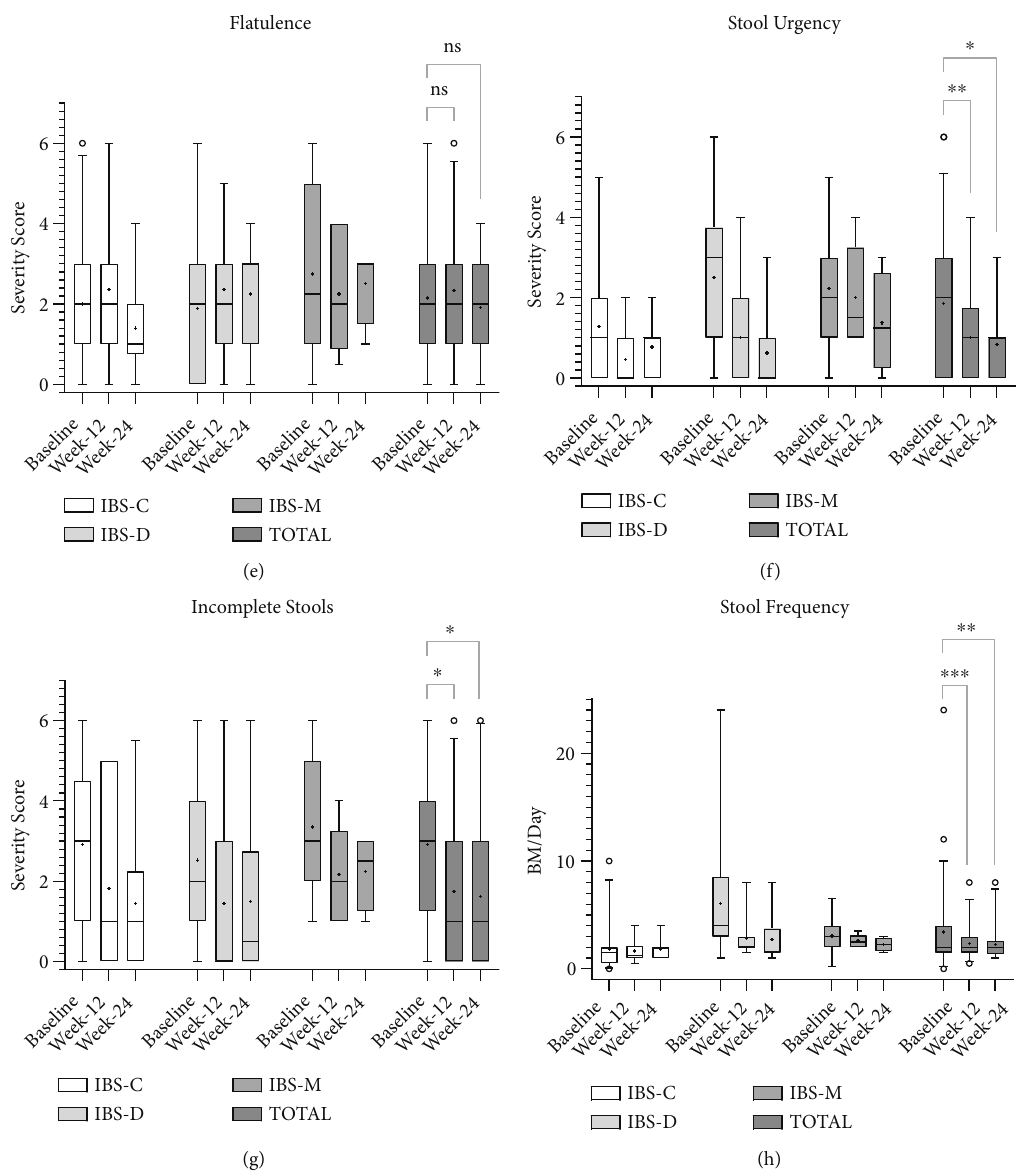
Figure 2: Abdominal symptom severity scores by IBS subtype and total cohort from baseline to week-24 ( N = 59 ). Scores of abdominal symptom severity for (a) – (g) were as follows; 0=none, 1=mild, 2=moderate, 3=quite a lot, 4=severe, 5=very severe, and 6=unbearable. Stool frequency (h) was recorded as bowel motions (BM) per day. A 5 – 95 percentile box and whisker plots (a) — (h) were generated in GraphPad Prism 8 with the median and quartiles marked as standard, the mean marked with a ‘ + ’ and outliers marked with a ‘ o ’ . Signi fi cance was graphed as follows; ns=not signi fi cant ( p > 0 : 05 ), * p ≤ 0 : 05 , ** p ≤ 0 : 01 , and *** p ≤ 0 : 001 . Week-52 data was omitted due to low questionnaire return